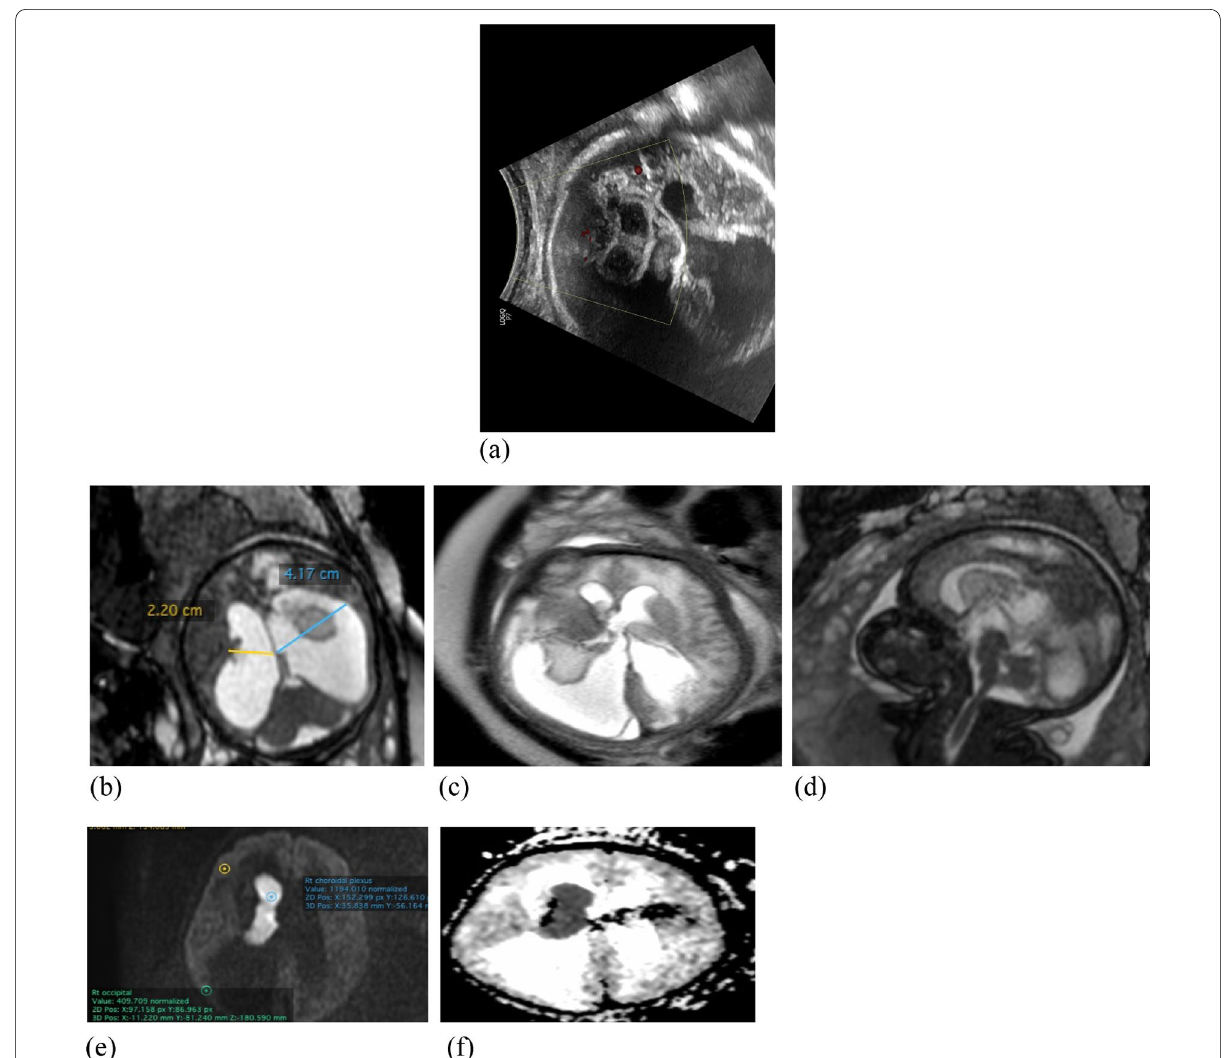
Fig. 4 Thirty-six-week fetus; prenatal US revealed ventriculomegaly and echogenic structure within the right lateral ventricle ( a ). SSFSE T2WIs axial planes b , c revealed supratentorial hydrocephalic changes reaching about 4 cm at the level of right atrium with ballooned occipital horns (colpocephaly), enlarged right choroid plexus (measuring 4.2 1.2 cm) eliciting intermediate signal with cystic changes, extending to the frontal × horn and cerebral parenchyma in the frontoparietal regions. Sagittal plane d shows agenesis of the corpus callosum with absent precentral gyrus. DWI and ADC e , f revealed evident diffusion restriction within the enlarged right choroid plexus with no diffusion restriction noted within the brain parenchyma. MRI diagnosis: Intraventricular hemorrhage with extension to the adjacent brain parenchyma and sever hydrocephalic changes down to the aqueduct (grade IV germinal matrix hemorrhage) with CC agenesis. Recommendation: Immediate delivery. Outcome: CS delivery followed by admission to NICU; the neonate died after few